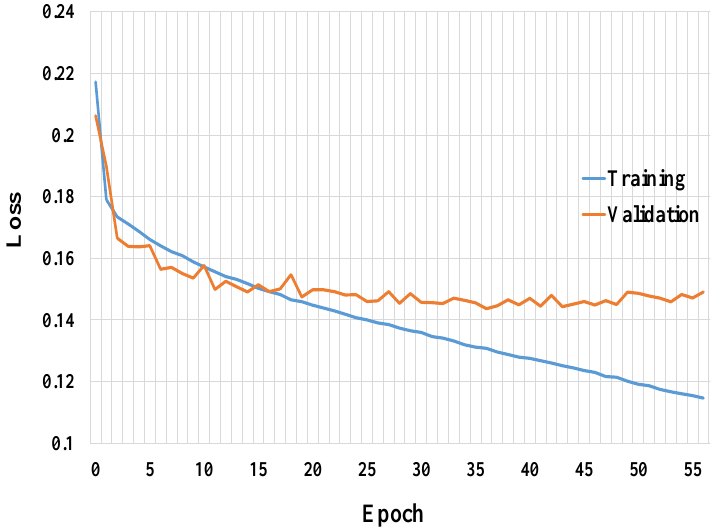
Figure 6. The training and validation loss curves of